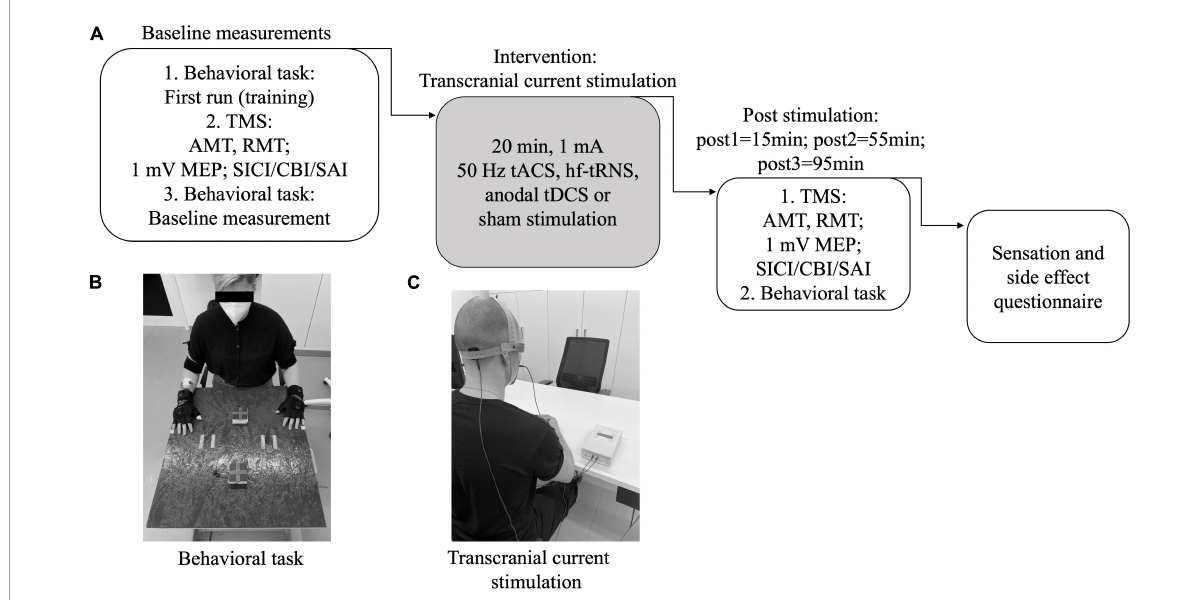
FIGURE1 Study design. (A) Experimental setup: In every session the timetable was as shown here. Before and after the plasticity induction the same measurements were performed. After the whole day, a questionnaire was answered. AMT, active motor threshold; RMT, resting motor threshold; MEP, motor evoked potential; SICI, short-interval intracortical inhibition; SAI, short-latency afferent inhibition; CBI, cerebellar brain inhibition; tACS, transcranial alternating current stimulation; tDCS, transcranial direct current stimulation; (hf-)tRNS, (high-frequency) transcranial random noise stimulation. (B) Experimental setup for behavioral task. (C) Setup for transcranial current